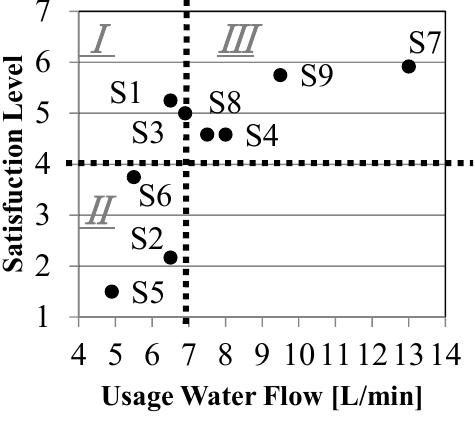
Figure 3. Relationship between usage water flow and satisfaction